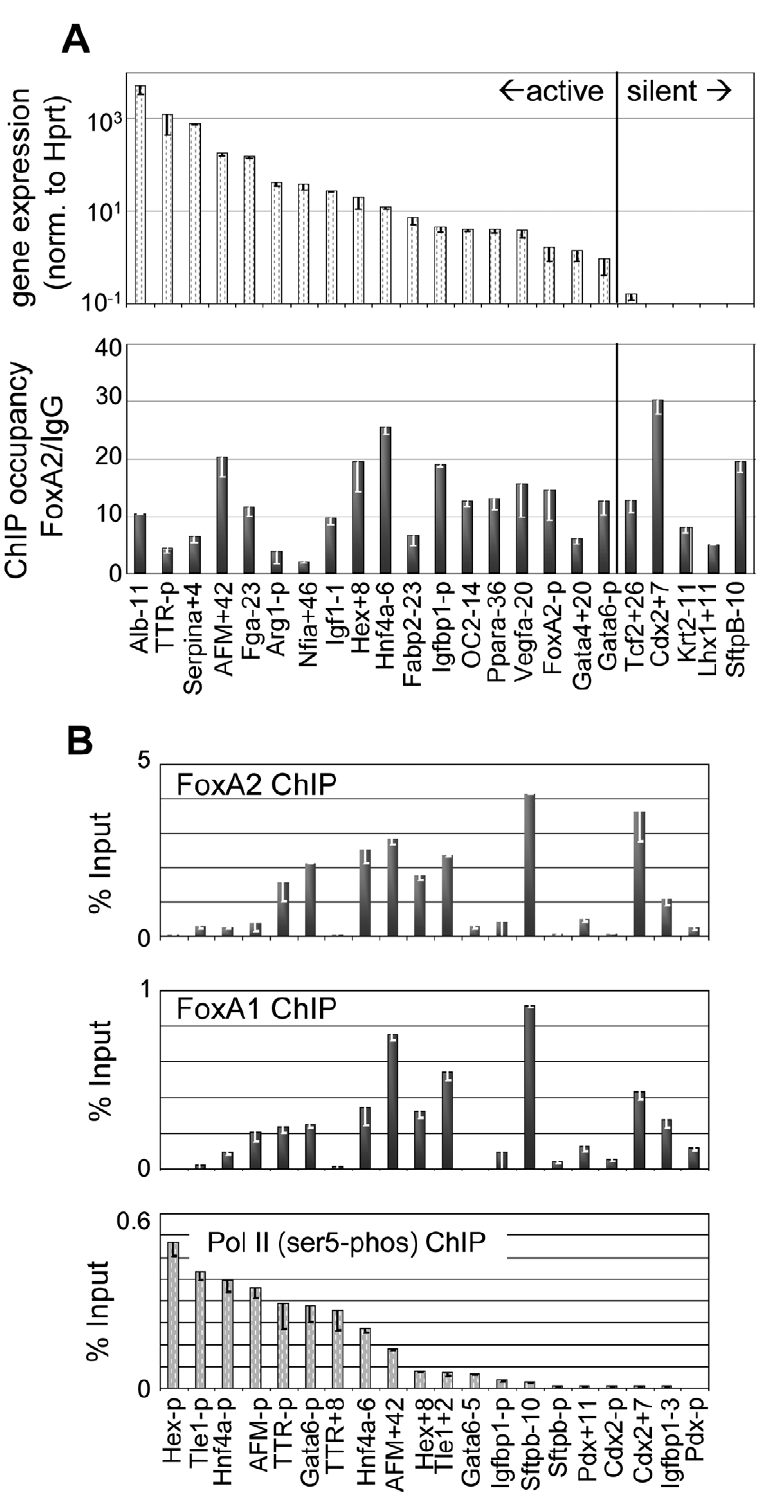
Figure 1. FoxA occupies silent targets in the adult liver. (A) Comparison of liver gene expression as determined by Taqman Low-Density Array to FoxA2 occupancy by ChIP after ranking genes by expression level. For genes with multiple FoxA target sites, the site with the strongest occupancy is indicated. (B) Site-specific ChIP of FoxA2, FoxA1 and Pol II Phospho-serine 5 at ChIP-chip identified targets and nearby control regions in liver. Sites are ranked by degree of Pol II occupancy, with signal as percentage of input after background subtraction.